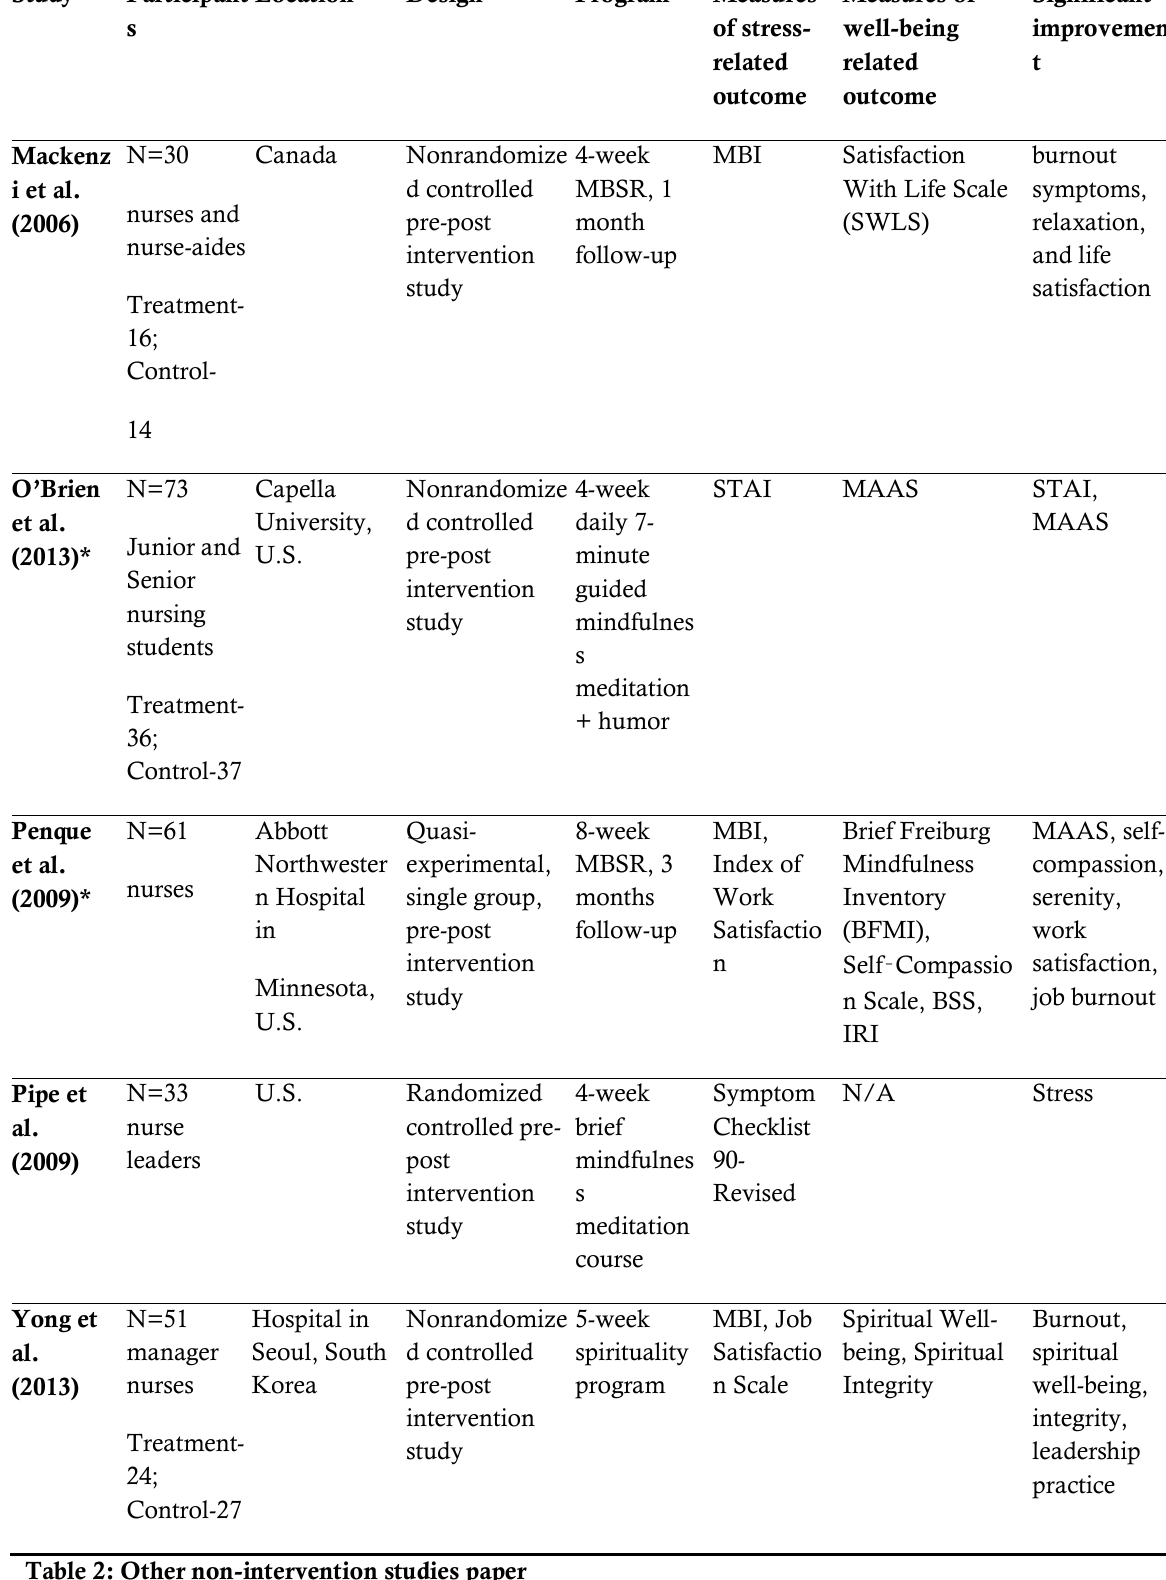
Table 2: Other non-intervention studies